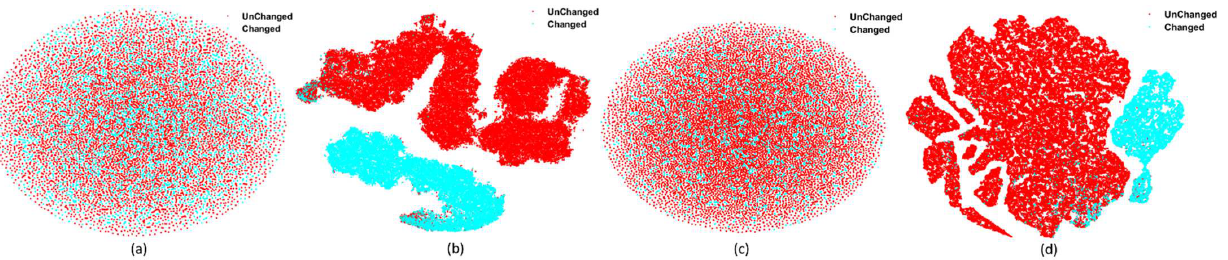
Figure 10. ROCs of different methods for the ( a ) Yancheng dataset ( b ) Hermiston dataset ( c ) River dataset ( d ) Bay Area dataset.